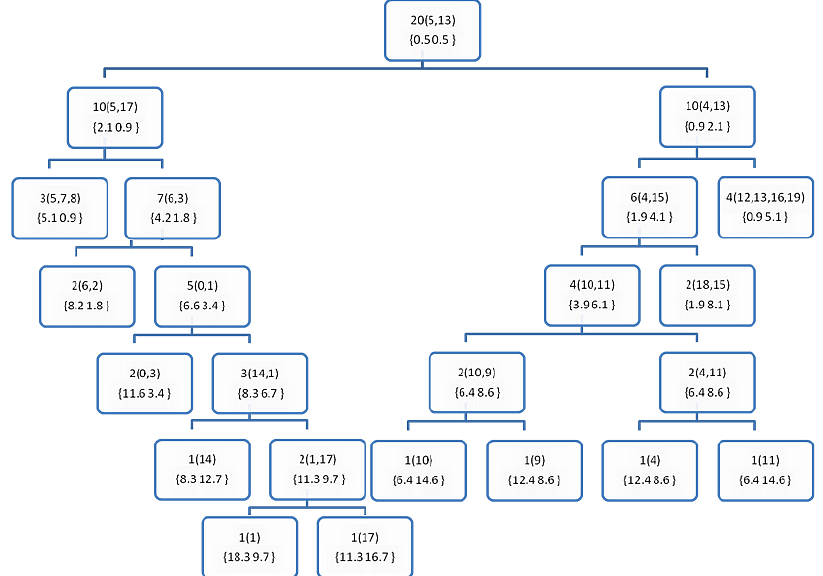
Figure 5. The resultant decision tree after applying the training phase of the DT1 on the sample data from Table 1. The number outside the rounded brackets is the counter of the examples hosted by each node, and those inside the rounded brackets are the index of the examples in a leaf node, or the furthest points (P1 and P2) otherwise. The numbers in the curly brackets {} shows the probabilities of the classes at each node.